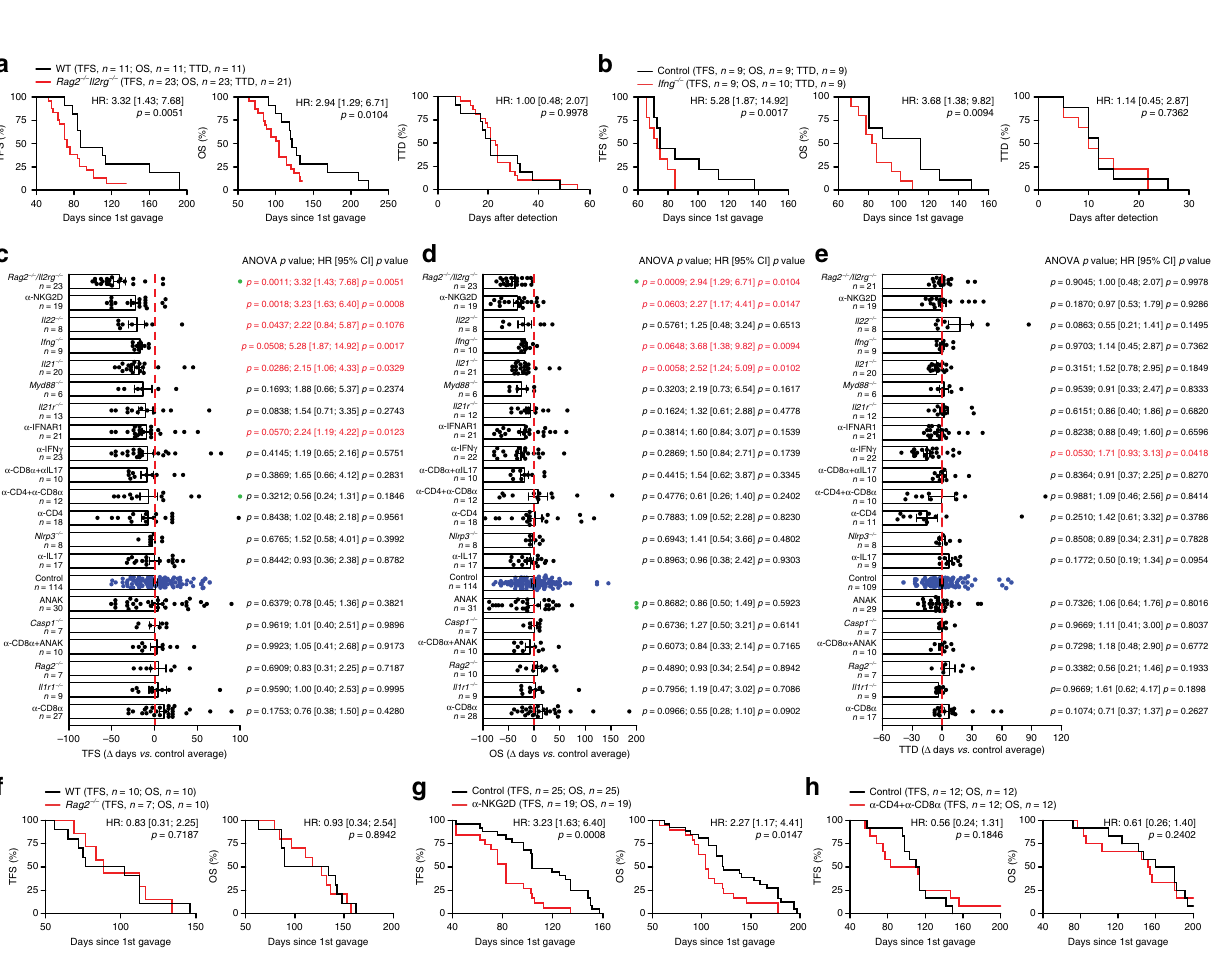
Fig. 2 M/D-driven oncogenesis is under immunosurveillance by NK cells. a , b Tumor-free survival (TFS), overall survival (OS) and time-to-death (TTD) of WT C57BL/6 mice ( a , b ) and Rag2 − / − Il2rg − / − mice ( a ) or Ifng − / − mice ( b ) subjected to M/D-driven oncogenesis. Number of mice, hazard ratio (HR) and p values (two-sided log-rank) are reported. c – e . Variations in TFS ( c ), OS ( d ) and TTD ( e ) imposed to M/D-driven oncogenesis in mice by the indicated genotype or immunomodulatory interventions. Results are means ± SEM plus individual data points. Number of mice, HR and p values (two-sided log-rank and one way-ANOVA plus Fisher LSD, calculated with respect to individual control experiments) are reported. Green dots indicate mice that were free of disease ( c ) and alive ( d ) at the end of the experiment. f – h TFS and OS of WT C57BL/6 ( f – h ) mice and Rag2 − / − BALB/c mice ( f ), C57BL/6 mice receiving NKG2D-depleting antibodies ( g ), or C57BL/6 mice receiving CD4- and CD8-depleting antibodies ( h ). Number of mice, HR and p values (two- sided log-rank) are oncogenesis in this setting (Fig. 2c). These effects were also Importantly, while M/D-driven oncogenesis was fostered by a manifest at the level of OS for the Ifng − / − and Il21 − / − genotypes severe immunode fi ciency affecting T lymphocytes, B cells and NK and for NKG2D + cell depletion (Fig. 2d). Disease progression cells ( Rag2 − / − Il2rg − / − genotype), TFS and OS in Rag2 − / − mice computed as time from detection to death (time to death, TTD) (who lack T lymphocytes and B cells, but have an intact NK cell was only accelerated by IFNG-neutralizing antibodies (Fig. 2e). compartment) 9 did not differ from TFS and OS in WT mice